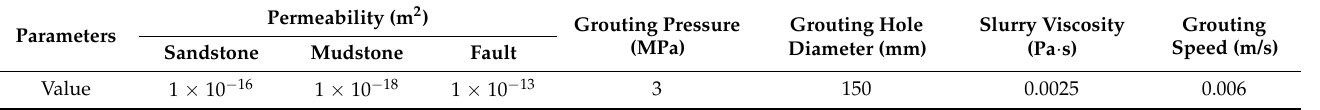
Table 2. Parameters for the large bed separation numerical model.